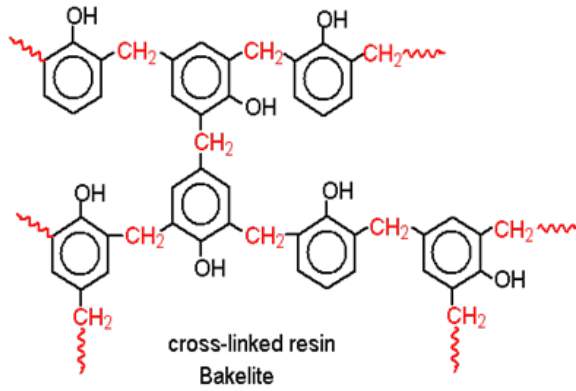
Figure 2: Molecular graph of